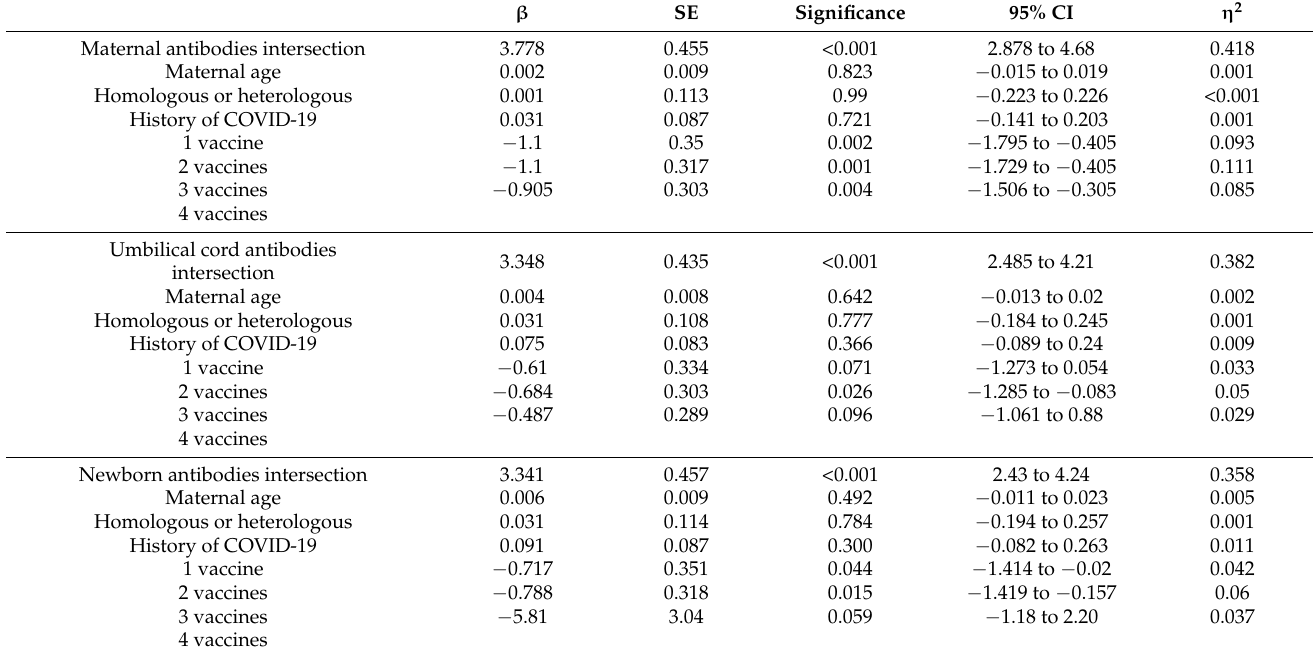
Table 5. Prediction of the numbers of anti-S1 and anti-S2 specific IgG antibodies for SARS-CoV-2. β